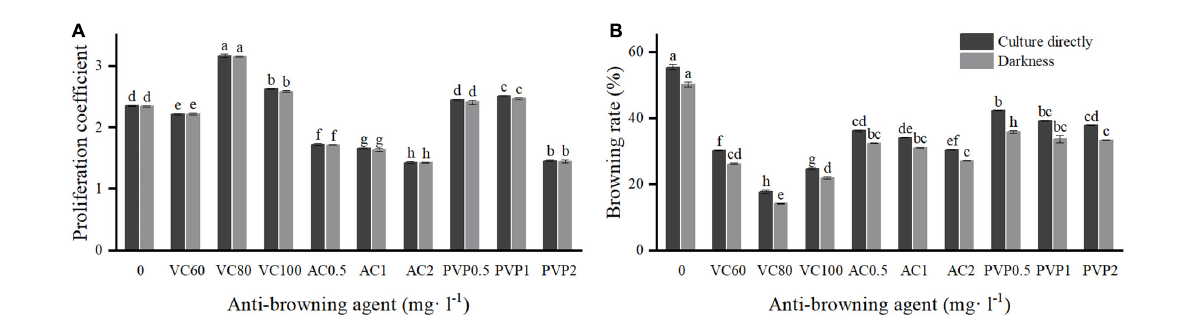
FIGURE1 Effects of different types and concentrations of anti-browning agents on shoot proliferation and browning. Group a (left) was cultured directly under light. Group b (right) was transferred to light culture after a 7-day darkness treatment. (A) Proliferation coefficient; (B) browning rate. Different uppercase letters in the same column indicate a significant difference, as per Duncan’s multiple range test ( p ≤ 0.05, n = 3 indicates three